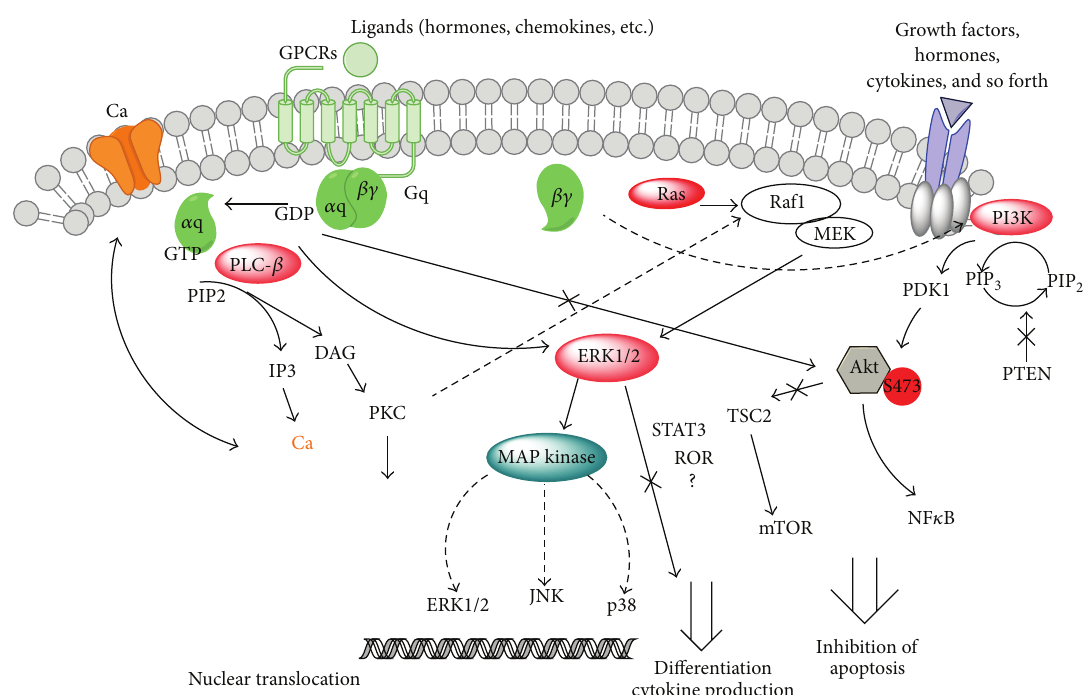
Figure 1: Signaling pathways demonstrating the link between Gq-coupled receptors and induction of autoimmunity. The figure shows the major signaling pathways that are believed to regulate the extracellular signals transduce into lymphocytes, which include the classic PLC- 𝛽 /PKC pathway (left) and inhibition of the PI3K-Akt pathway to maintain normal immune tolerance (right) while Gq can also facilitate the activation of the ERK-MAPK pathway, regulating the differentiation of lymphocytes and controlling the expression of cytokines